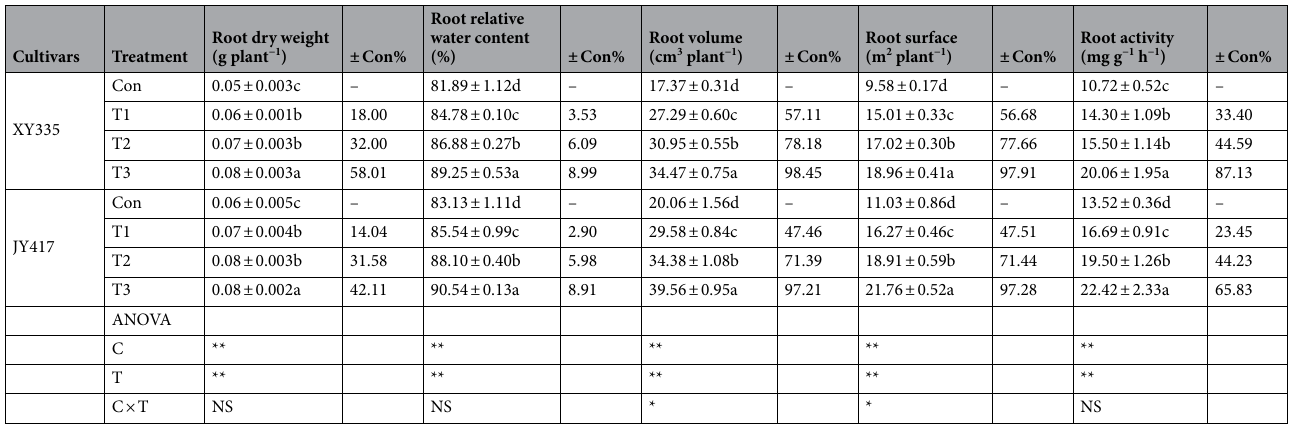
Table 4. Influence of T. asperellum on the root growth characteristic of maize seedlings rhizosphere soil (± SD). Con, T1, T2, and T3 indicate 0, 1 × 10 3 , 1 × 10 6 , 1 × 10 9 spores L −1 suspension, respectively. Root growth characteristics were measured on the 27th day after T. asperellum application. C and T indicated cultivars and treatments, respectively. Different small letter within a column represented significant differences at 5% probability level, and the numerical value was the mean of five repeats. Differences between treatments were calculated for each particular cultivar. NS, not significant. * and **, significant at the 0.05 and 0.01 probability level, respectively.